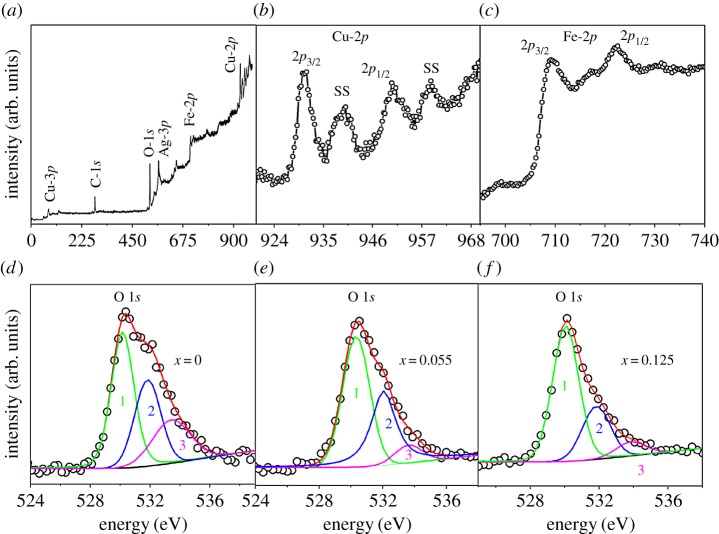
(a) XPS survey spectrum and high-resolution scans of (b) Cu 2p and (c) Fe 2p of Cu0.875Fe0.125O. The O 1s edge spectra of Cu1-xFexO samples; (d) x = 0, (e) x = 0.055 and (f) x = 0.0125.